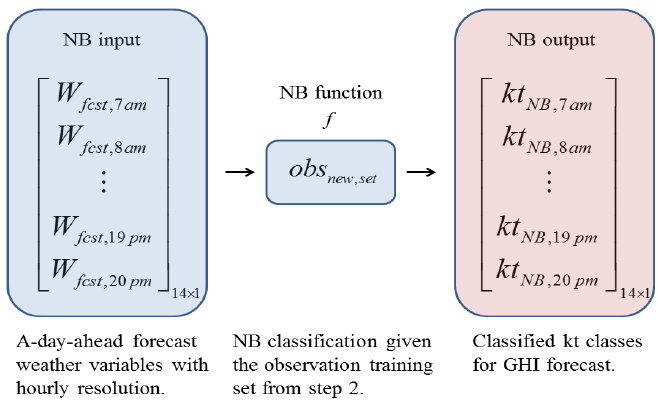
Figure 5. Modified NB classification using forecasted weather variables (step 3).